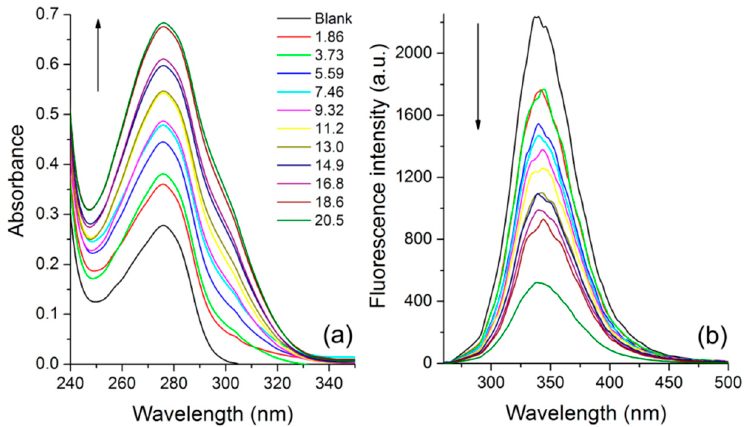
Figure 6. UV-Vis absorption ( a ) and fluorescence emission ( b ) spectra ( λ exc = 279 nm) of BSA in PBS solution (7.33 mM) in the presence of different amounts of spiropyran (10 -5 M). The blank sample is pure BSA.